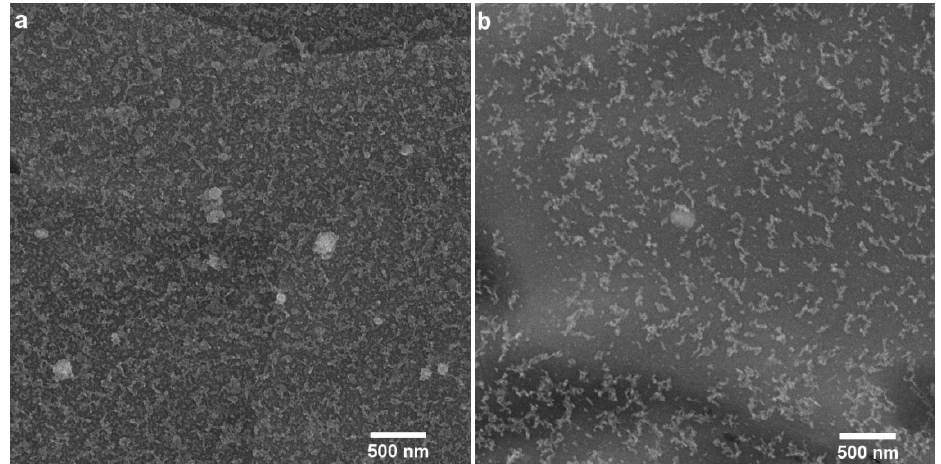
Figure 5. Precipitate distribution in two alloy specimens containing 0.1% Sc under thermomechanical treatment with 50% deformation at 120 °C for 12 h: ( a ) with controlled quenching, and ( b ) with conventional dissolution.